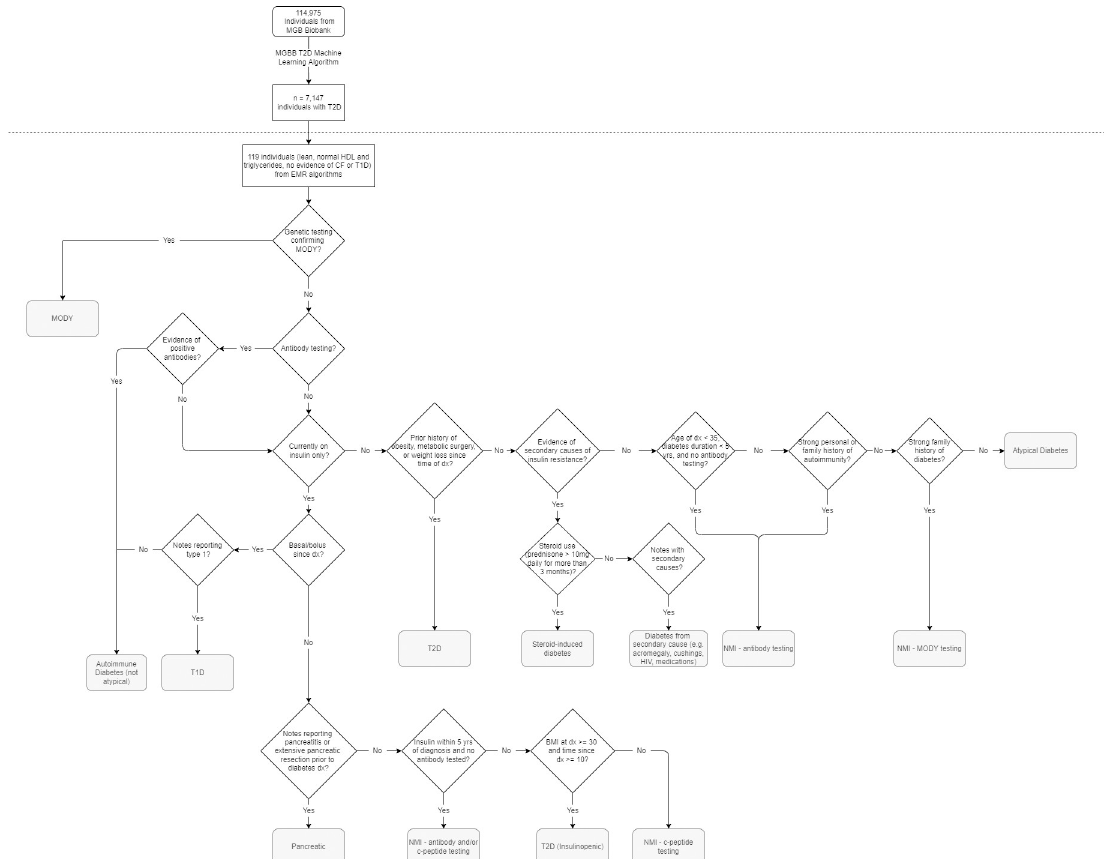
Fig 2. Method for classification of diabetes type. Research assistants summarized and endocrinologists manually reviewed identified charts to classify patients into one of three categories: atypical diabetes (AD), not AD (including typical type 1, type 2, LADA, MODY, pancreatic, steroid-induced, and secondary diabetes), and need more information (NMI). Methodology for classification of diabetes based on clinical data including interpretation of genetic testing, lab values, medication use, and medical history. MGB: Mass-General Brigham; MGBB: Mass-General Brigham Biobank; T2D: type 2 diabetes; HDL: high-density lipoprotein; CF: cystic fibrosis; T1D: type 1 diabetes; EMR: electronic medical records; MODY: maturity-onset diabetes of the young; dx: diagnosis; yrs: years; NMI: need more information; BMI: body mass